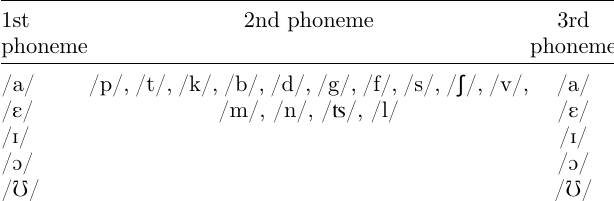
Table 2. VCV set of logatomes. For each of the 14 consonants in the 2nd phoneme column, fi ve logatomes are constructed using the row pairs of the 1st and 3rd